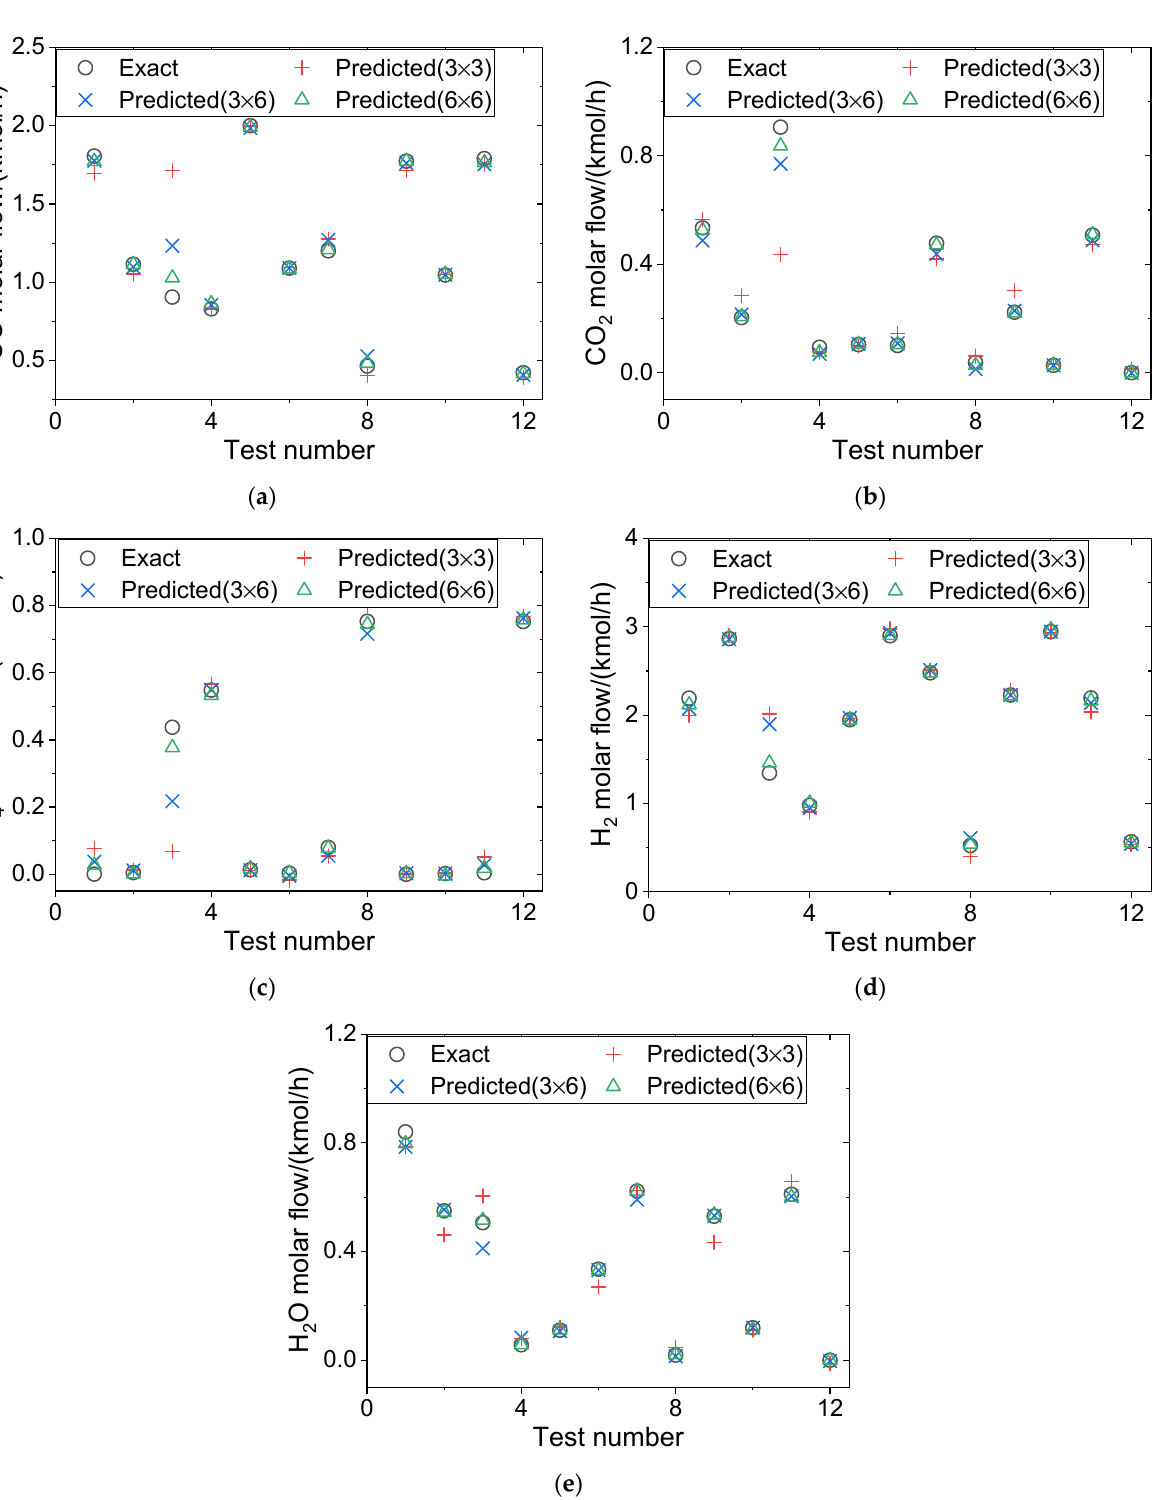
Figure 8. Prediction results of the cases with operating conditions beyond the range of training process: ( a ) CO; ( b ) CO 2 ; ( c ) CH 4 ; ( d ) H 2 ; ( e ) H 2 O.